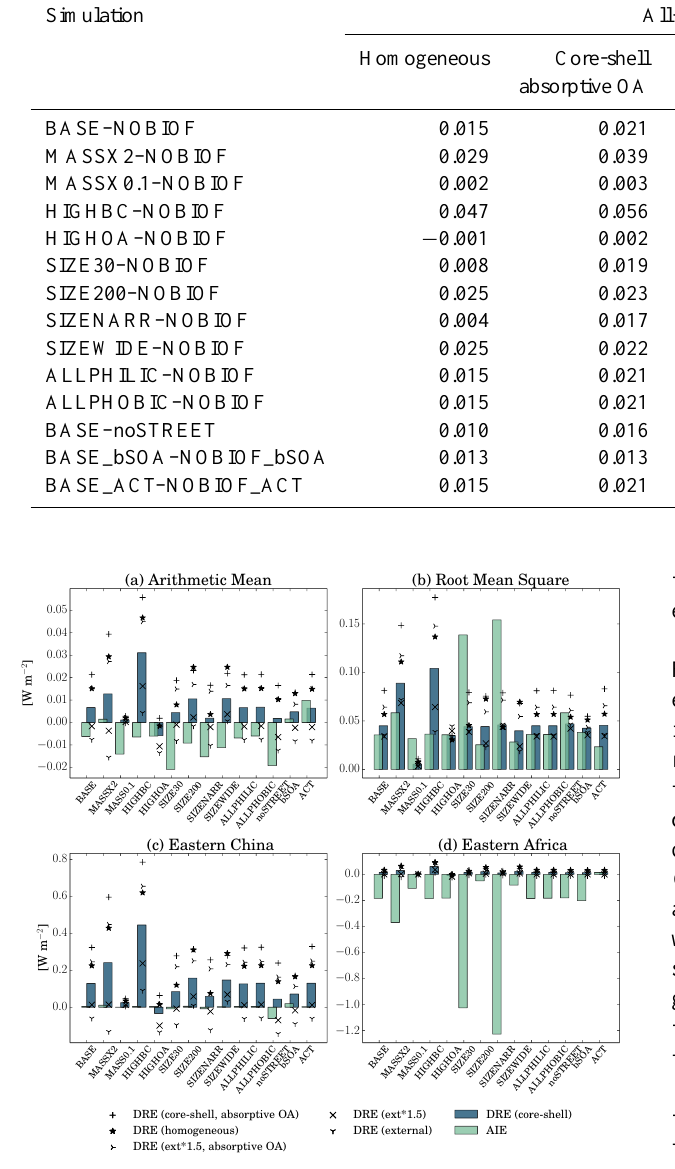
Figure 2. The DRE and AIE of biofuel aerosol (relative to a NO- BIOF simulation) for each simulation as (a) a global arithmetic mean, (b) global root mean square, (c) the value over eastern China, (d) the value over eastern Africa. The various symbols show alter- nate mixing-state